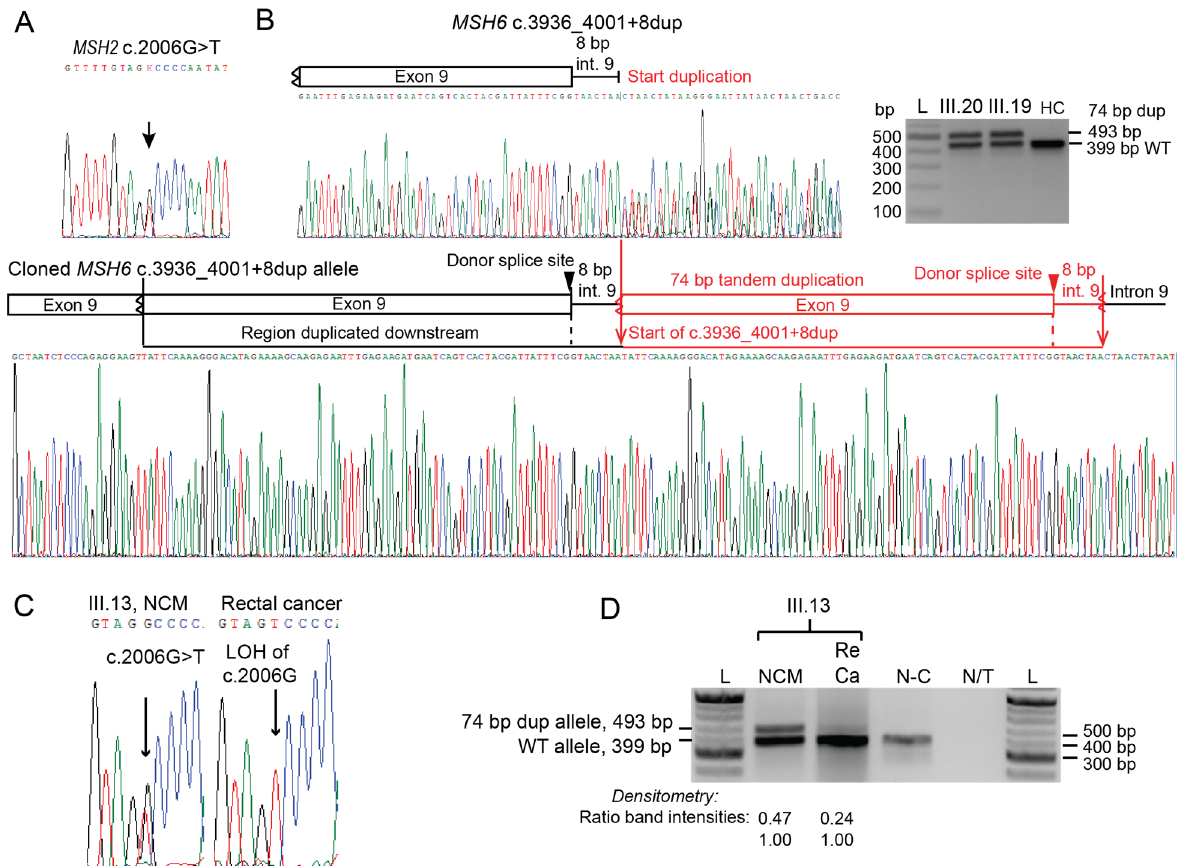
Figure 2. Carriage of both MSH2 and MSH6 variants by the proposita and proband and loss of heterozygosity of the wild-type MSH2 allele in the proband’s rectal tumor. ( A ) Sequence electrophero- gram across the MSH2 c.2006G>T variant site in genomic DNA from the proposita, III.20, shows she is a heterozygous carrier. ( B ) Left, sequence electropherograms across the MSH6 c.3936_4001+8dup (Intronic) variant in the proposita showing a heterozygous frameshift mutation, and beneath, the cloned duplicated variant allele showing the complex structure of the MSH6 c.3936_4001+8dup (In- tronic) variant. Right, photograph of electrophoresis gels showing the size-fractionated PCR frag- ments across the MSH6 c.3936_4001+8dup (Intronic) variant in saliva DNA from the proposita (III.20) and her older sister (III.19) showing both are heterozygous for this germline variant (upper frag- ment). HC, healthy control saliva DNA. ( C ) Sequence electropherogram across the MSH2 c.2006G>T variant in DNA isolated from formalin-fixed paraffin-embedded normal colorectal mucosa (NCM) and rectal cancer tissues from the deceased proband, III.13, shows complete loss-of-heterozygosity (LOH) of the wild-type allele in the tumor. ( D ) Photograph of electrophoresis gels showing the size- fractionated PCR fragments across the MSH6 c.3936_4001+8dup (Intronic) variant in genomic DNA from NCM, the rectal cancer (Re Ca) from the proband and peripheral blood lymphocytes from a non-carrier (N-C) of the MSH6 variant. The fragment intensities from densitometry of the WT and duplicated fragments are shown beneath. The NCM showed reduced amount of the duplicated al- lele compared to the WT allele, with further reduction of the duplicated allele in the tumor. Original blots see Supplementary File S1.